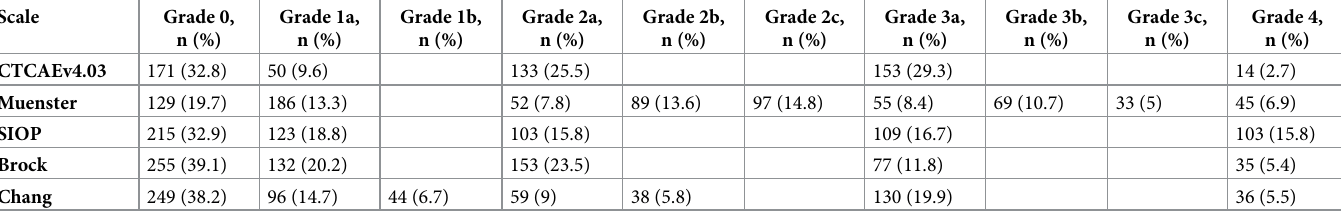
Table 3. Grade distribution (%) based on the last available audiogram according to different CTCAEv4.03, Muenster, SIOP, Brock and Chang classification systems. Scale